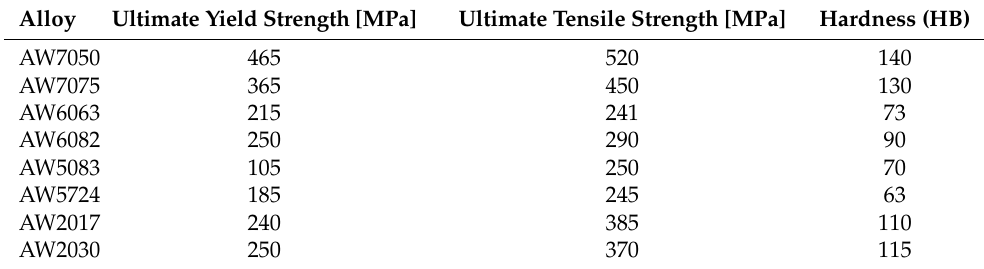
Table 2. Mechanical properties values for the considered aluminum